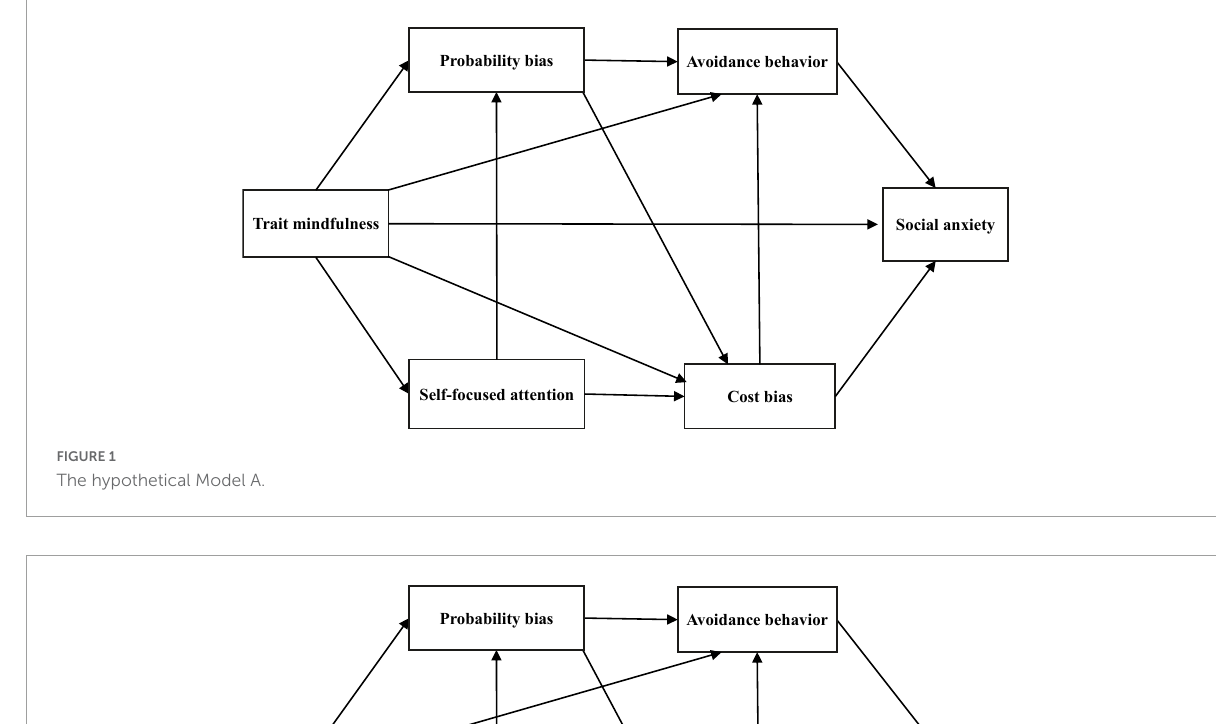
FIGURE1 The hypothetical Model A.